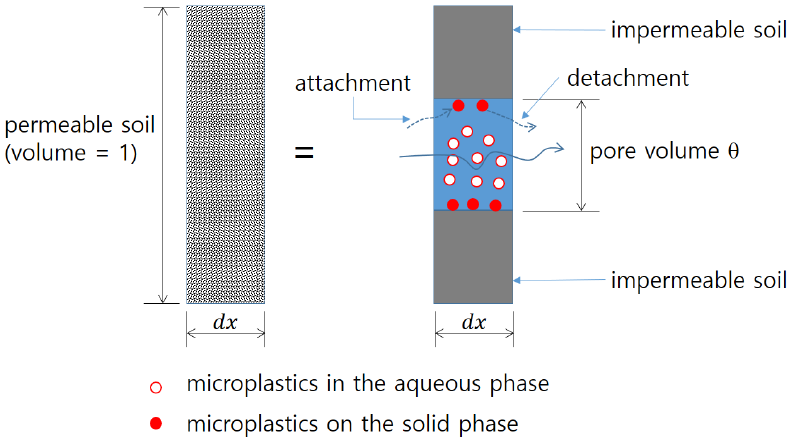
Figure 1. Transport of MPs in a saturated porous